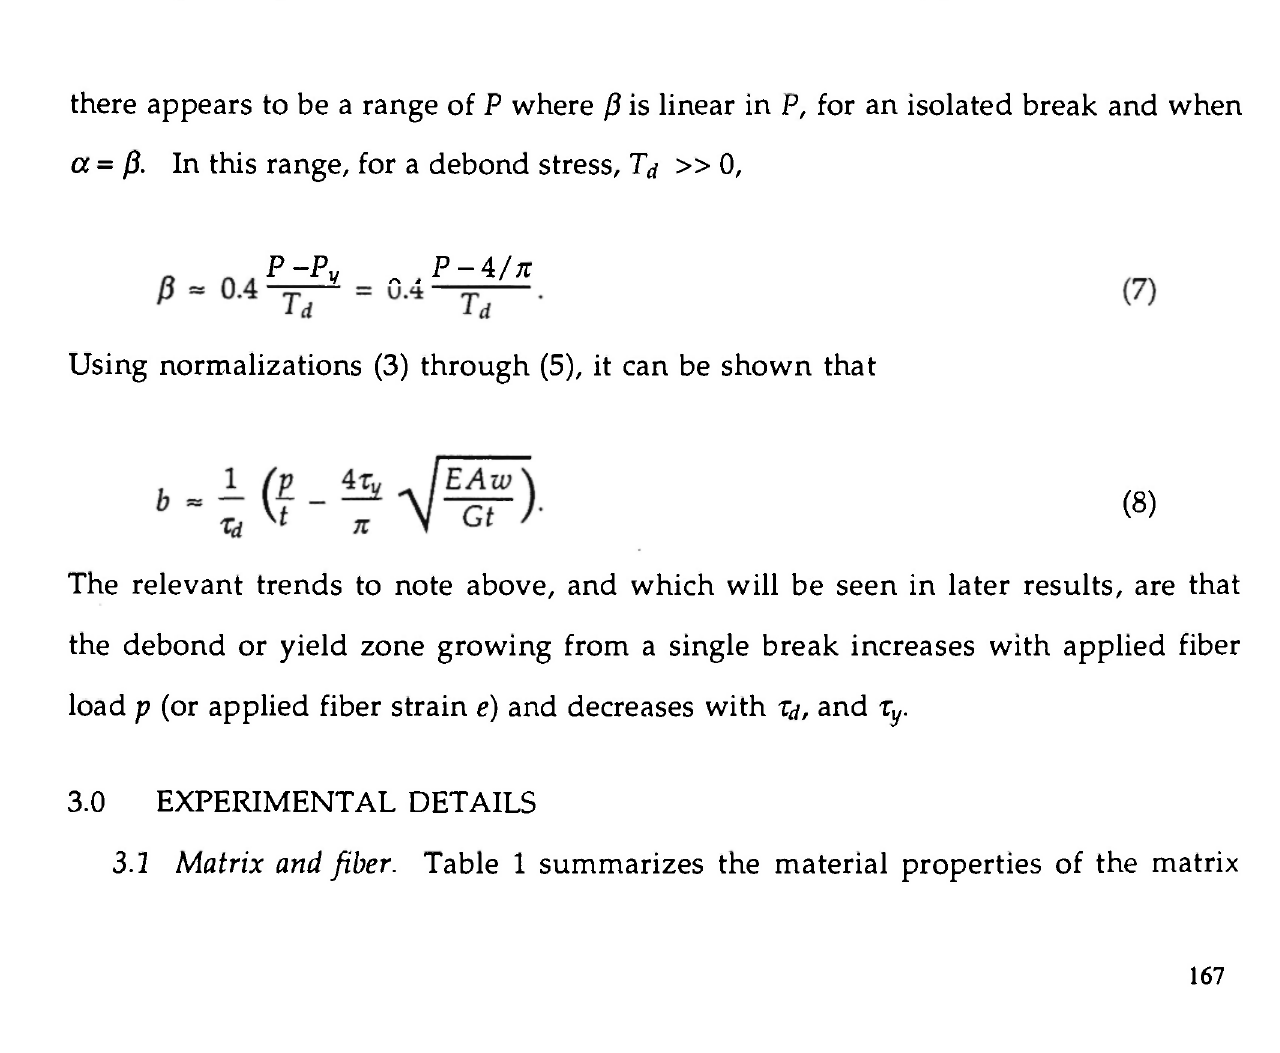
Fig. 5: The extent of the yielded (Τα = T y = 1.0) or debonded [Ta < 1.0 = T y ) region, quarter plane about an isolated fiber break versus the applied tensile load a, in a